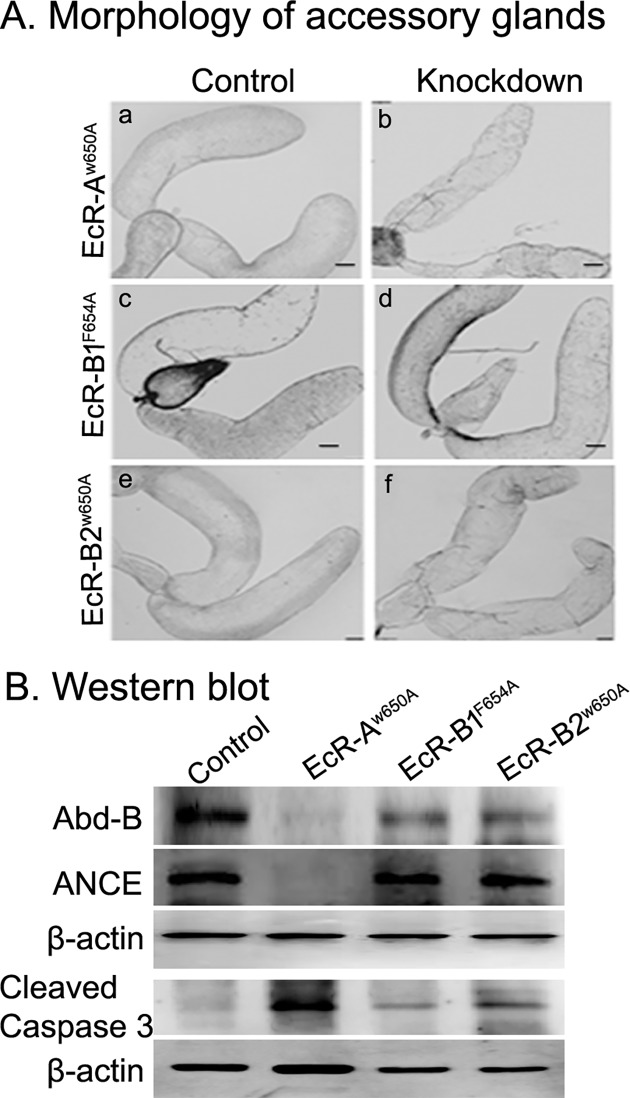
Morphology and secondary cells markers of accessory glands in males over-expressing dominant negative EcR isoforms.The morphology of accessory glands from (A) control or males over expressing (B) EcR-A, (C) EcR-B1, or (D) EcR-B2 was observed under light microscopy. Morphology of accessory glands from males over expressing EcR-B1, or EcR-B2 is comparable to their controls. However, accessory glands from EcR-A appear slightly reduced in comparison to their controls but still not as extremely reduced as those in EcR-miRNA based knockdown males. (B) Western blots of accessory gland protein extracts depicting levels of Abd-B (Abd-B panel), ANCE (ANCE panel) proteins and cleaved Caspase 3 immunoreactivity (cleaved Caspase 3 panel) in males over expressing EcR-A, EcR-B1 and EcR-B2. Blots were probed with β-actin antibodies (β-actin panels) served as controls for protein loading.